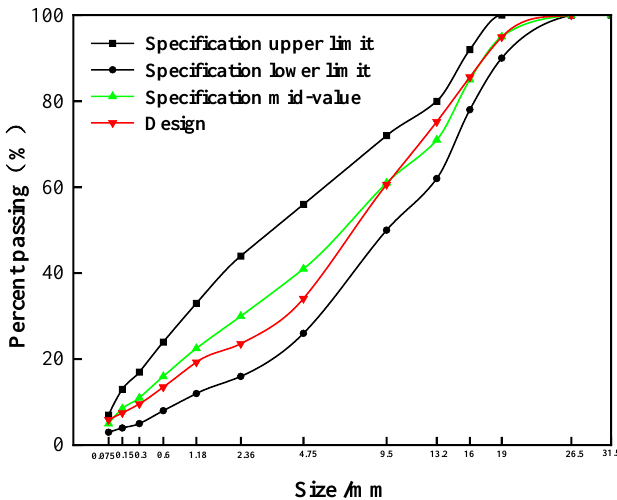
Figure 3. AC20 aggregate gradation curves.